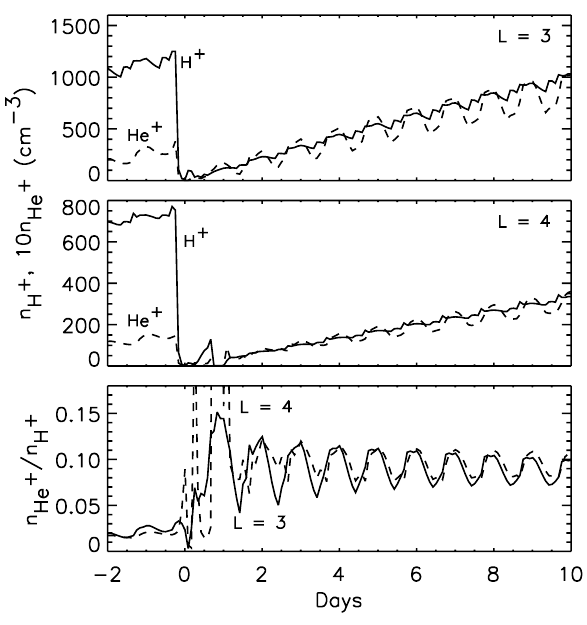
Fig. 3. H + and He + densities versus time, with the He + density scaled up by factor of 10, for longitude 0, winter, and high solar activity. Densities are given at the magnetic equator for L = 3 (top panel) and L = 4 (middle panel). He + /H + density ratios are also plotted (bottom